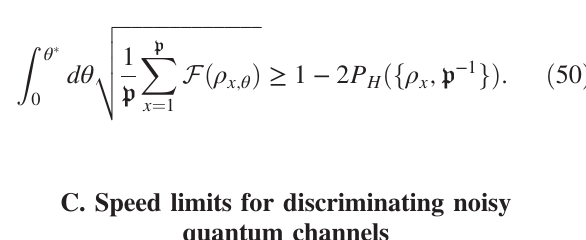
FIG. 4. Intuitive representation of the geometrical argument connecting the error in the discrimination of p quantum channels with the precision of random